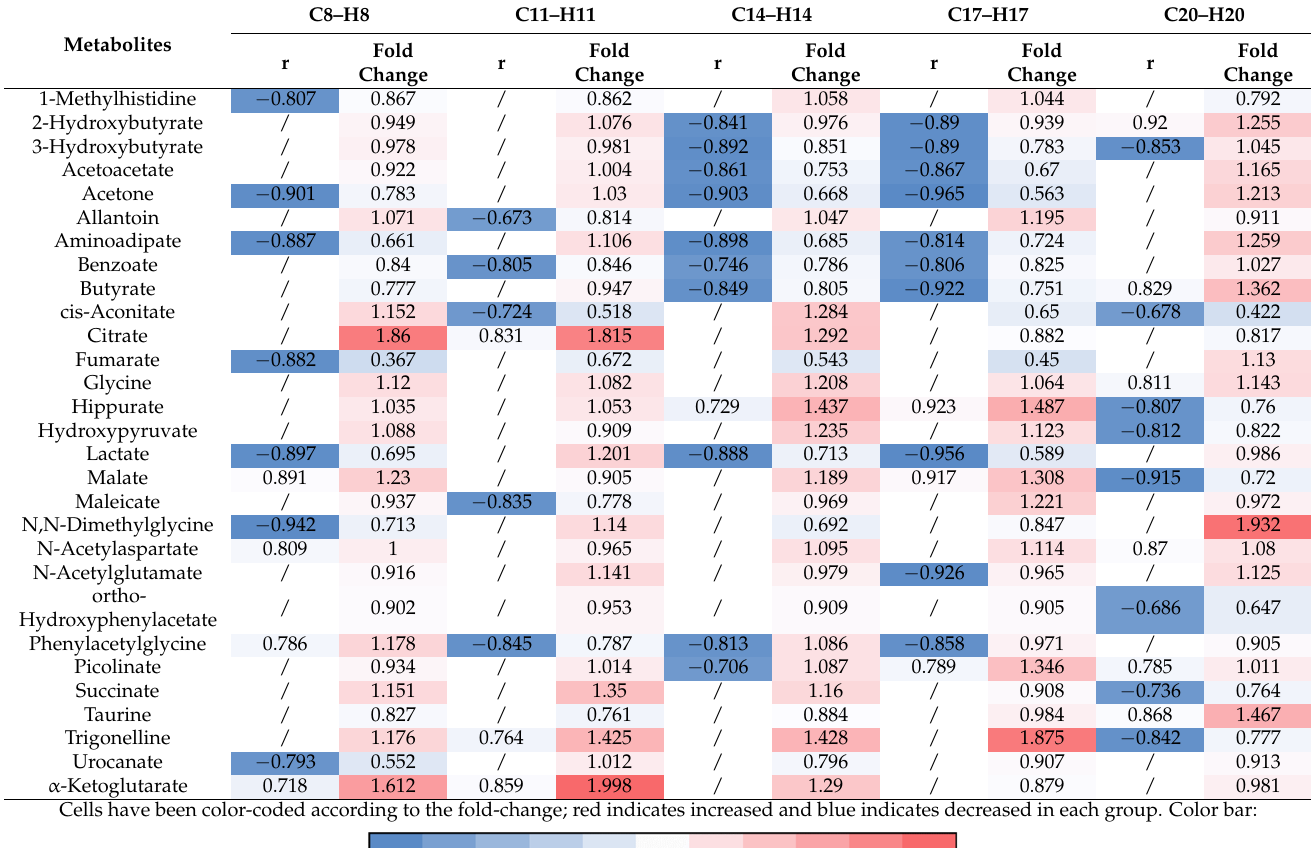
Table 2. Differences in urine metabolism between hypoxia group and control group.